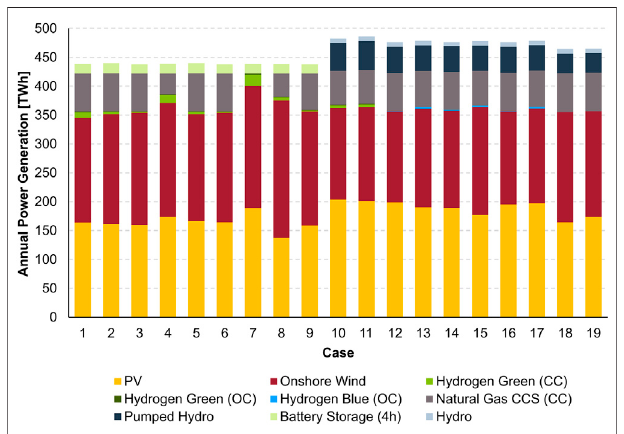
FIGURE 5 | Normalized total annual power generation by technology type for each